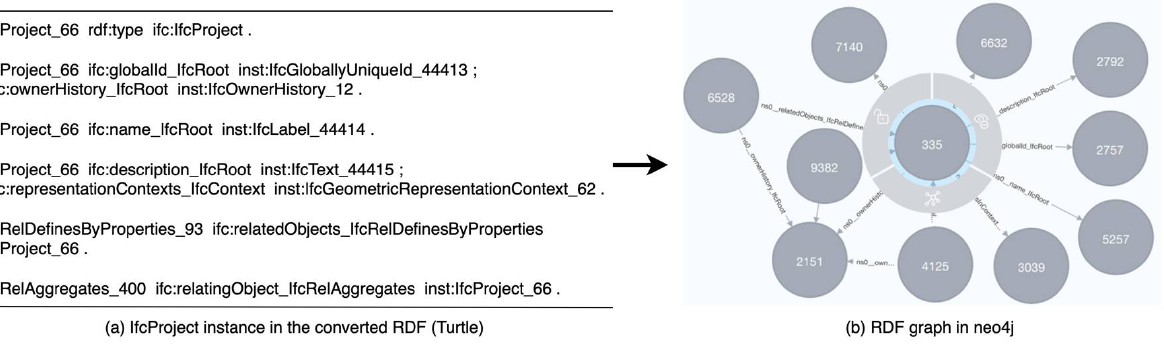
Figure 14. RDF data in ( a ) Turtle and ( b ) LPG